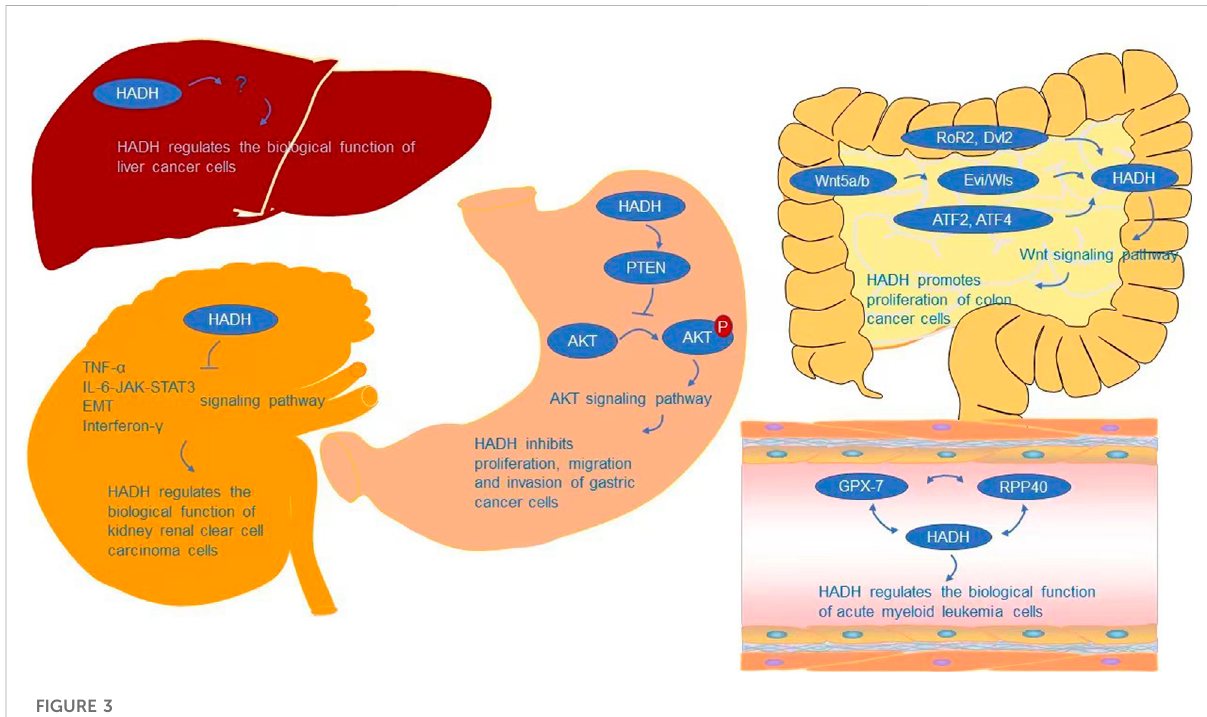
FIGURE 3 Underlying molecular mechanisms of HADH in